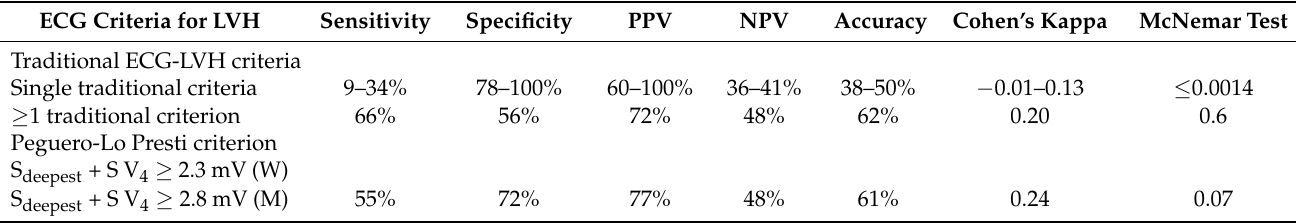
Table 2. Diagnostic performance of the Peguero-Lo Presti criterion and traditional ECG-LVH criteria to predict echocardio- graphic LVH.